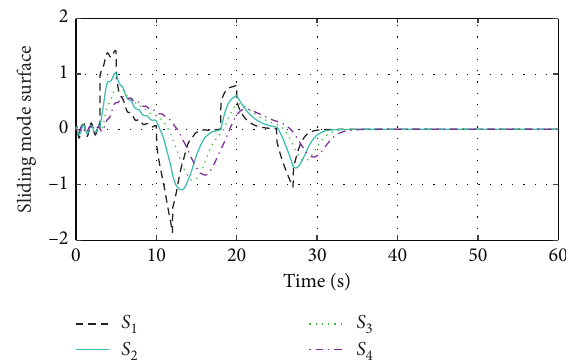
Figure 3: Sliding mode surface.